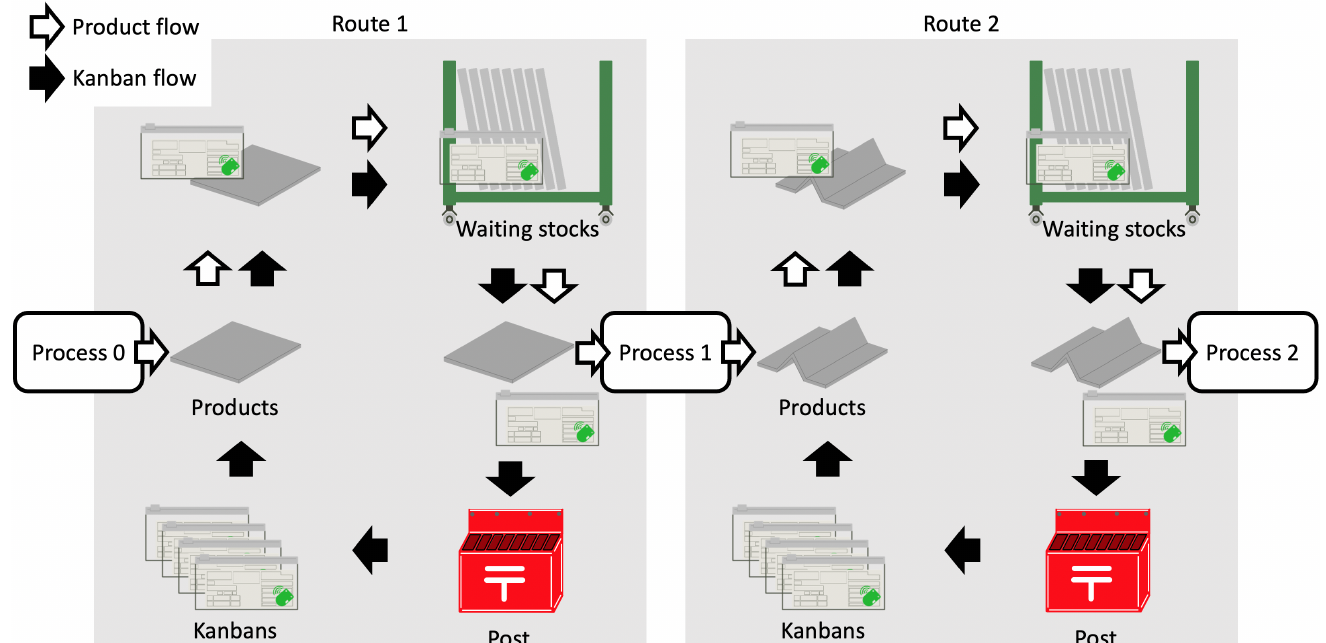
Figure 3. Assumed flows of the products and